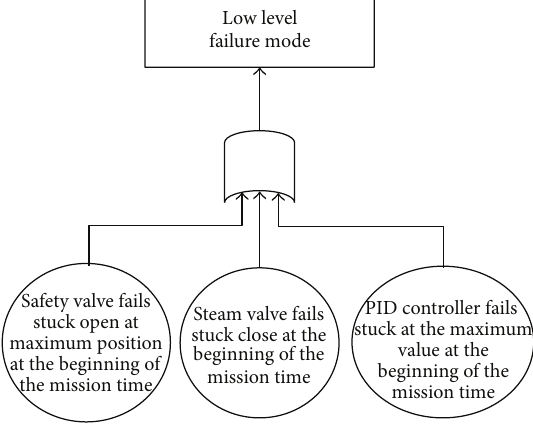
Figure 20: Fault tree for the low level failure mode at low